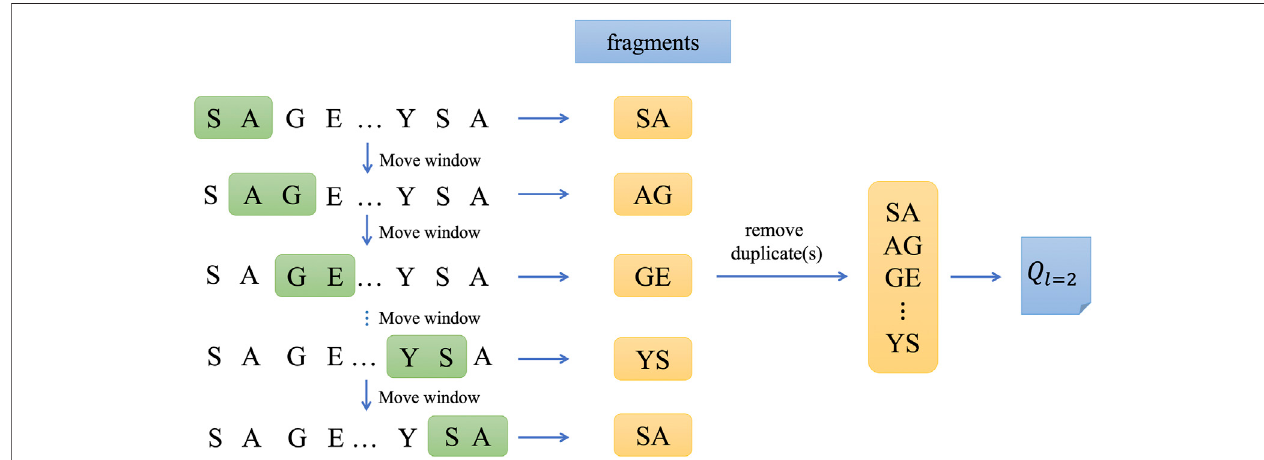
FIGURE 2 | The process of splitting sequences and forming wordbook of Q l (cid:2) 2 .